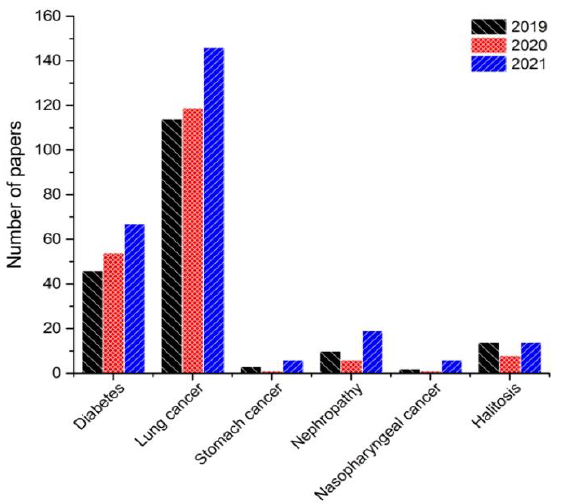
Figure 1. Number of papers in 2019 – 2021 related to the analysis of biomarkers of diseases.